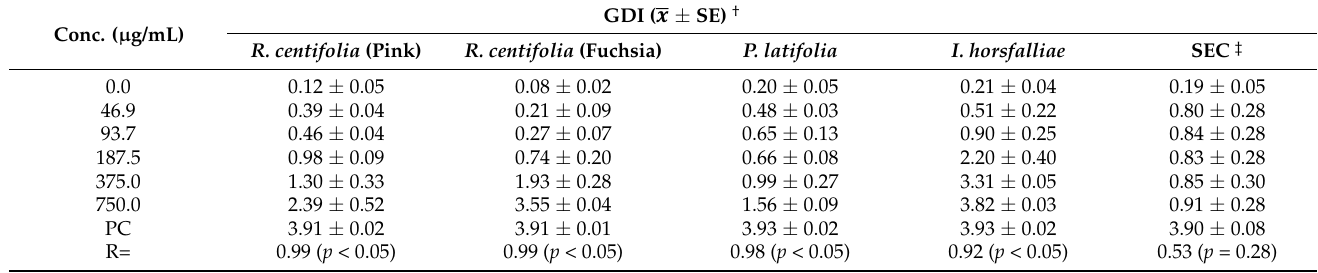
Table 2. Genotoxicity of the flower extracts in MRC5 human fibroblasts cells. The genetic damage in- dex (GDI) values and their corresponding standard errors, calculated from at least three independent experiments, are given. Pearson correlation coefficients (R) showing the relationship between GDI extract concentrations are also presented.